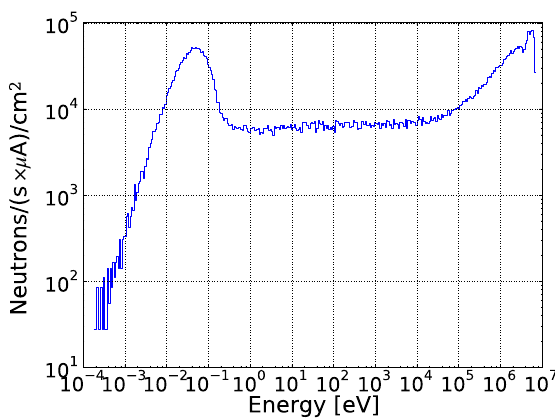
Figure 3: Simulated neutron energy spectrum at the exit port of the current moderator/shielding